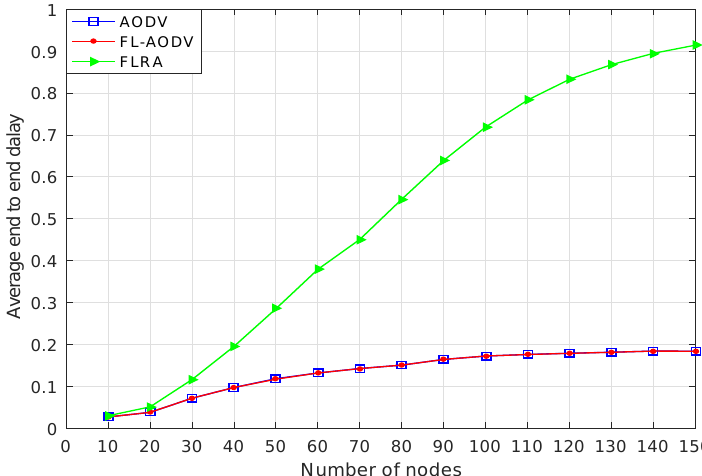
Figure 10. Comparison of average end-to-end